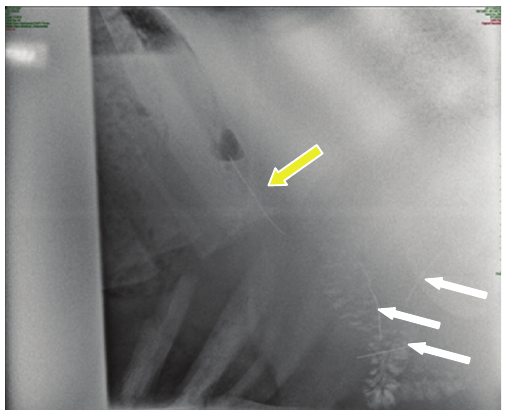
Figure 2: Laterolateral radiograph taken at the level of the retic- ulum and diaphragm. The intrathoracic foreign body and gas shadows could be seen cranial to the reticulum (yellow arrow). The lung and diaphragm could not be di ff erentiated because of the increased soft tissue opacity. Three thin metallic opaque foreign bodies could be seen in the cranial epigastric abdomen in the region of the reticulum (white